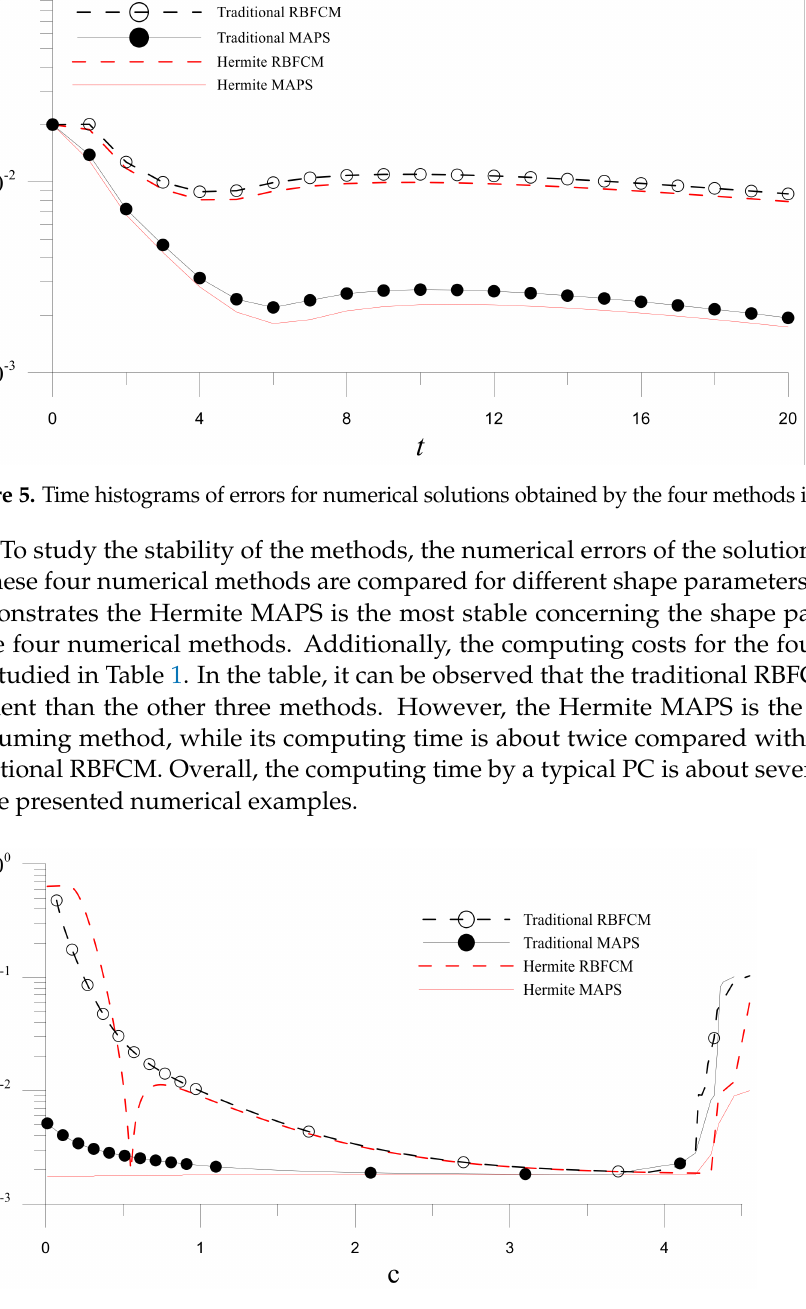
Figure 6. Errors of numerical solutions obtained by the four methods with different values of c at t = 6 for Example 1. Table 1. Computing time (s) for numerical solutions by the four methods in Example 1 ( c = 1, θ = 1, ∆ t = 0.1, and t = 0 ∼ 5